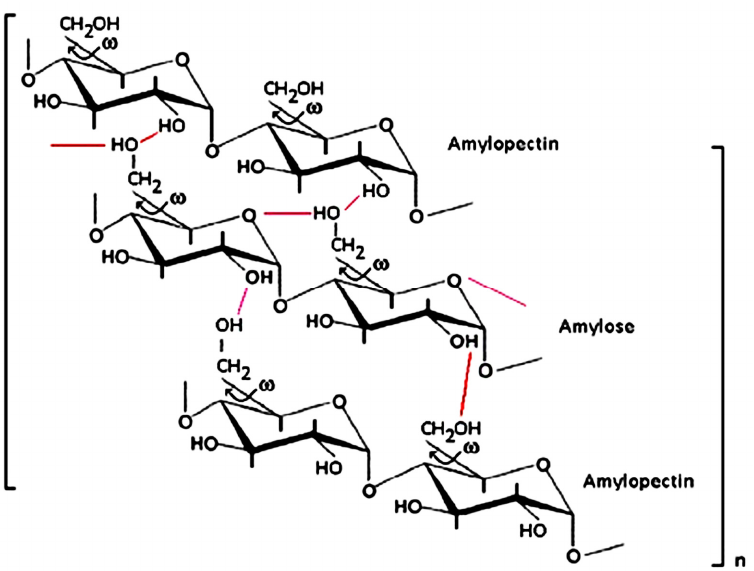
Scheme 5. Retrogradation mechanism of rice, potato, and wheat starch. The red lines represent hydrogen bonding.